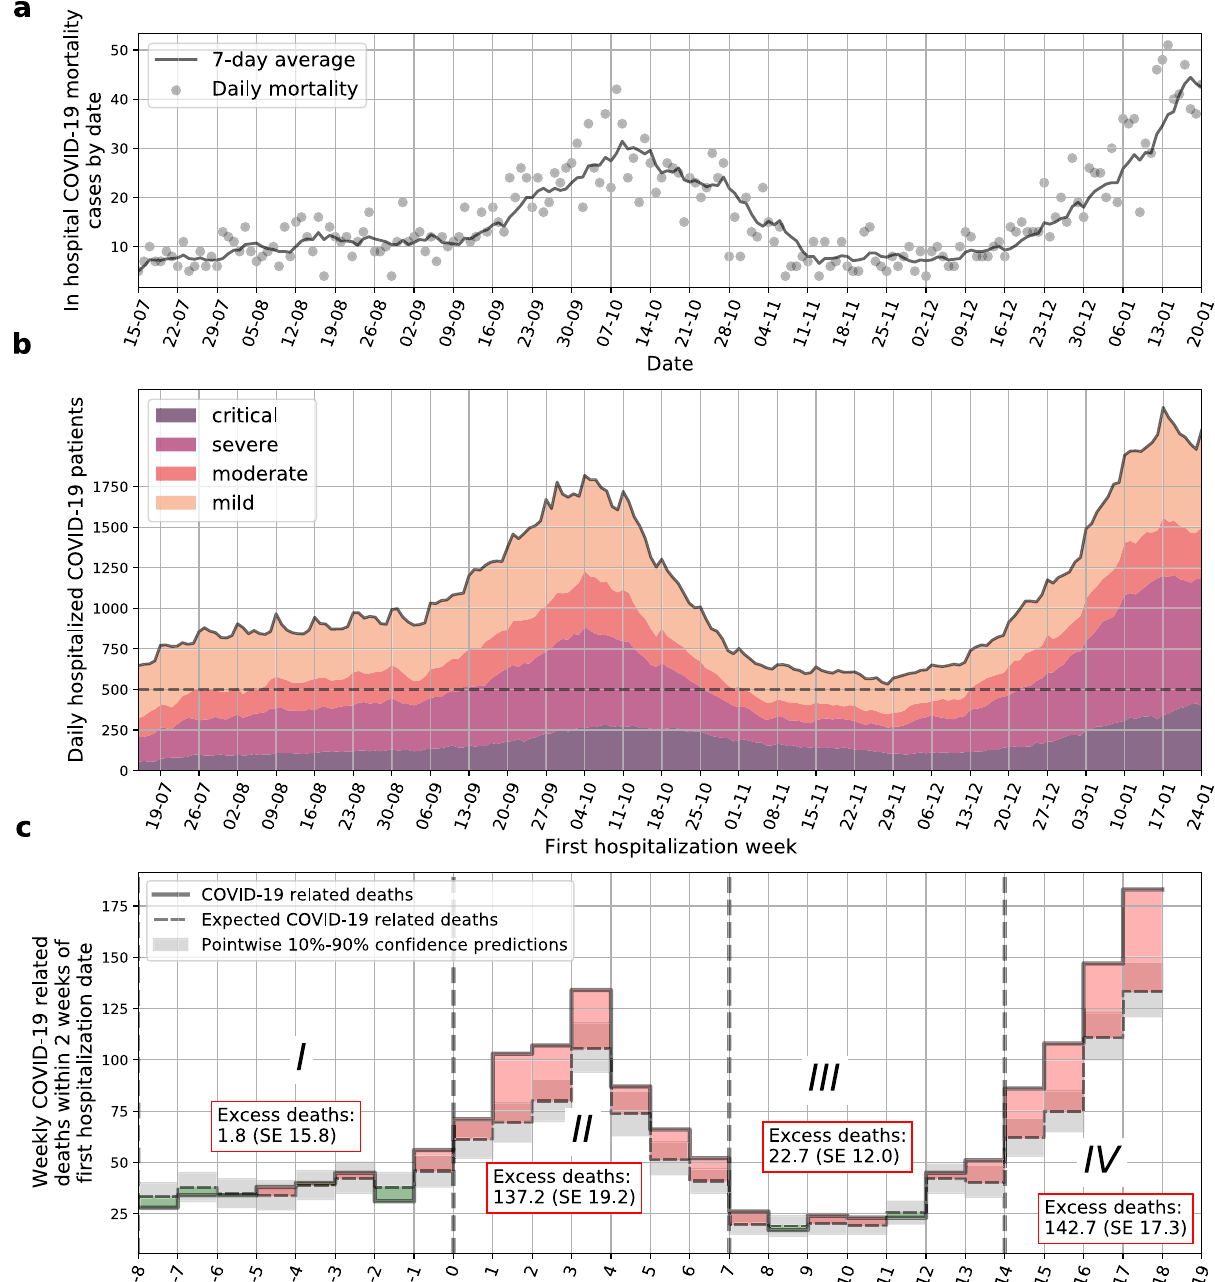
Fig. 1 Hospital load and increased COVID-19 related mortality. a In hospital COVID-19 related mortality cases by date. Daily mortality is marked by gray circles, and a 7-day average is plotted as a solid line. b Number of COVID-19-related hospitalizations by day in all hospitals in Israel. Colors depict different clinical states. A threshold of 500 severe and critical patients per day is presented by a dashed horizontal line. Dashed vertical lines separate weeks which are over/under this threshold. c COVID-19 related deaths for sets of patients that were fi rst hospitalized in different weeks. Observed deaths for each week are marked by a solid line. Expected deaths as predicted from the model are marked in dashed black line. Monte-Carlo-based pointwise 10 – 90% con fi dence predictions are marked in gray. Weeks in which excess deaths were observed (positive difference between true and expected curves) are fi lled in red; and weeks in which deaths were overestimated (negative difference between true and expected curves) are fi lled in green. X -axis is marked by the week number. SE standard